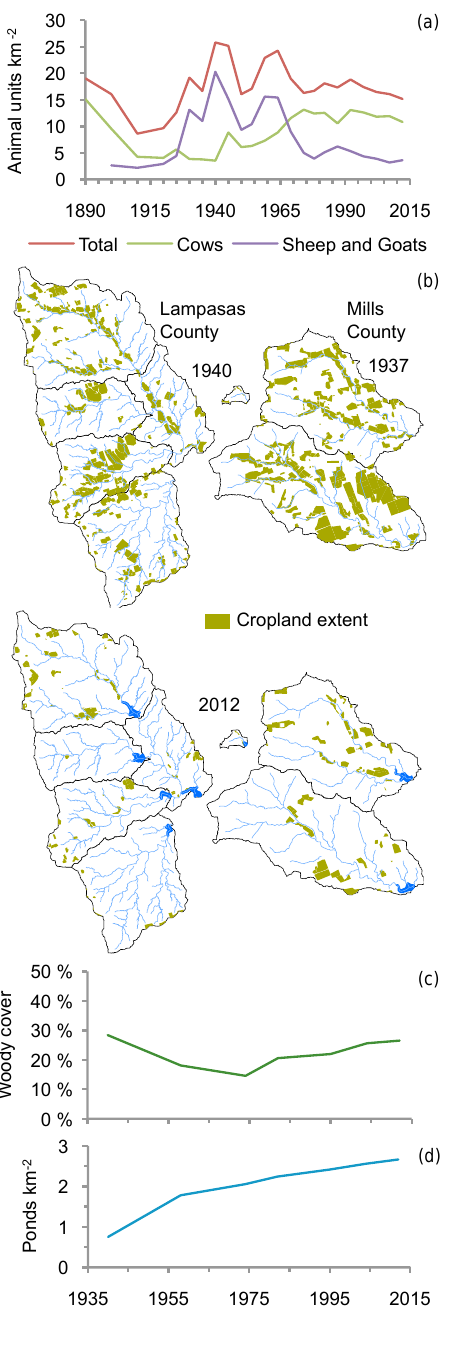
Figure 3. Historical landscape changes in the study area. (a) Live- stock numbers in the Lampasas Cut Plain. Recreated from Wilcox et al. (2012a). (b) Extent of active cropland in 1937–1940 and 2012 (Berg et al., 2016). (c) Historical extent of woody plant cover in the study watersheds (Berg et al., 2015b). (d) Pond density over time in the study watersheds (Berg et al., 2015a).